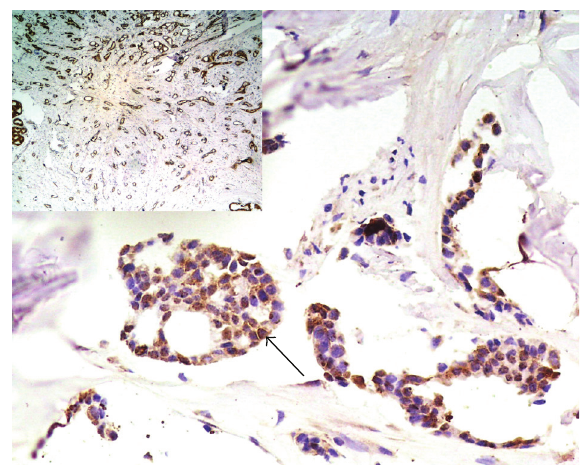
Figure 5: Occurrence of NUCKS in invasive ductal carcinoma, GI. The positive staining in this case was the least frequent in comparison to cases of IDC GII and GIII. ABC method. Magnification 200x, inset 40x.